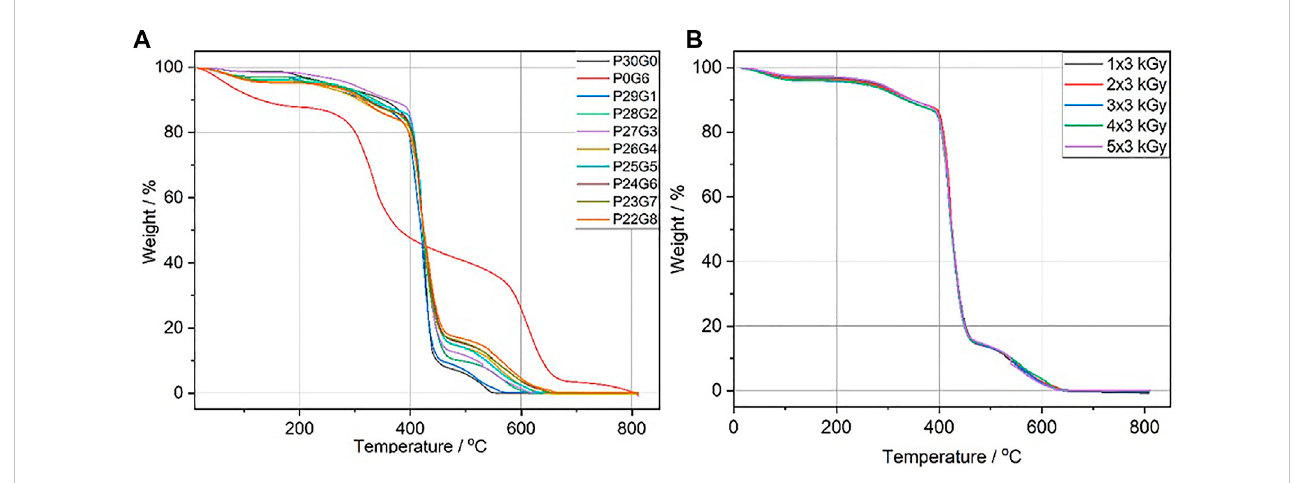
FIGURE 5 Thermal stability ofhydrogels (A) atdifferentPEGDA/gelatinratios and fi xedelectron dose of6 kGy (B) P26G4 hydrogel irradiatedwith differentelectron irradiation